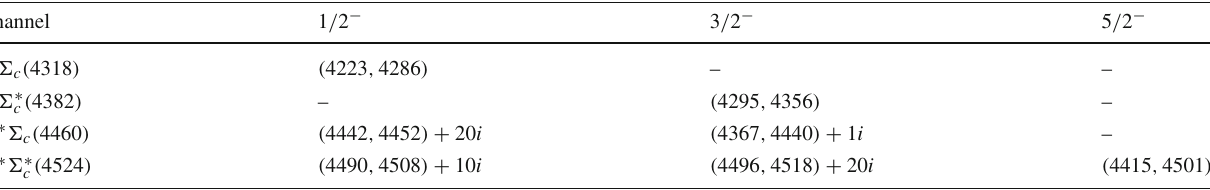
units of MeV and the corresponding thresholds are listed in the brackets in the first column